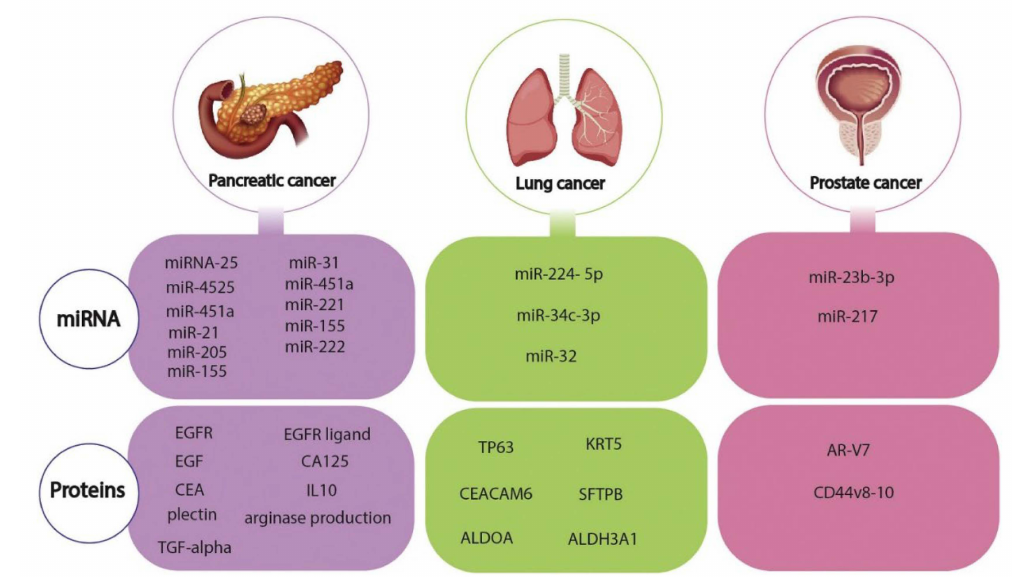
Figure 1. Diagram showing the miRNAs and protein-based pancreatic, lung and prostate cancer biomarkers. Reprinted with permission from Ref [73]. Copyright 2022,